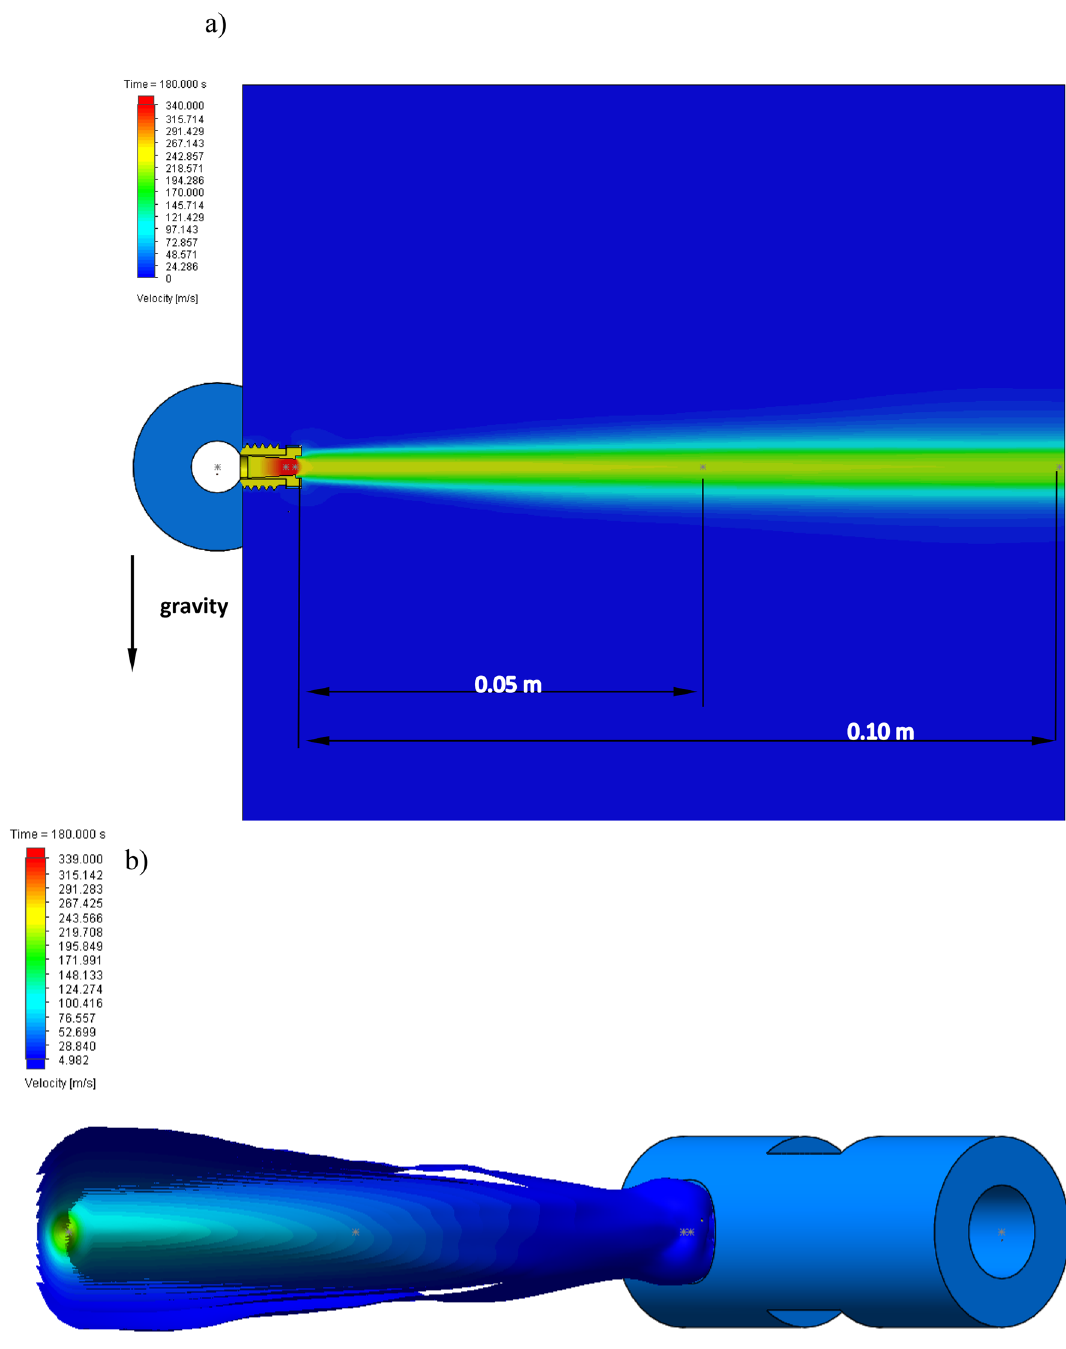
Figure 11. A map of water velocity changes: ( a ) cross-section and ( b )